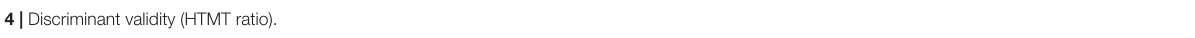
TABLE 4 | Discriminant validity (HTMT ratio).